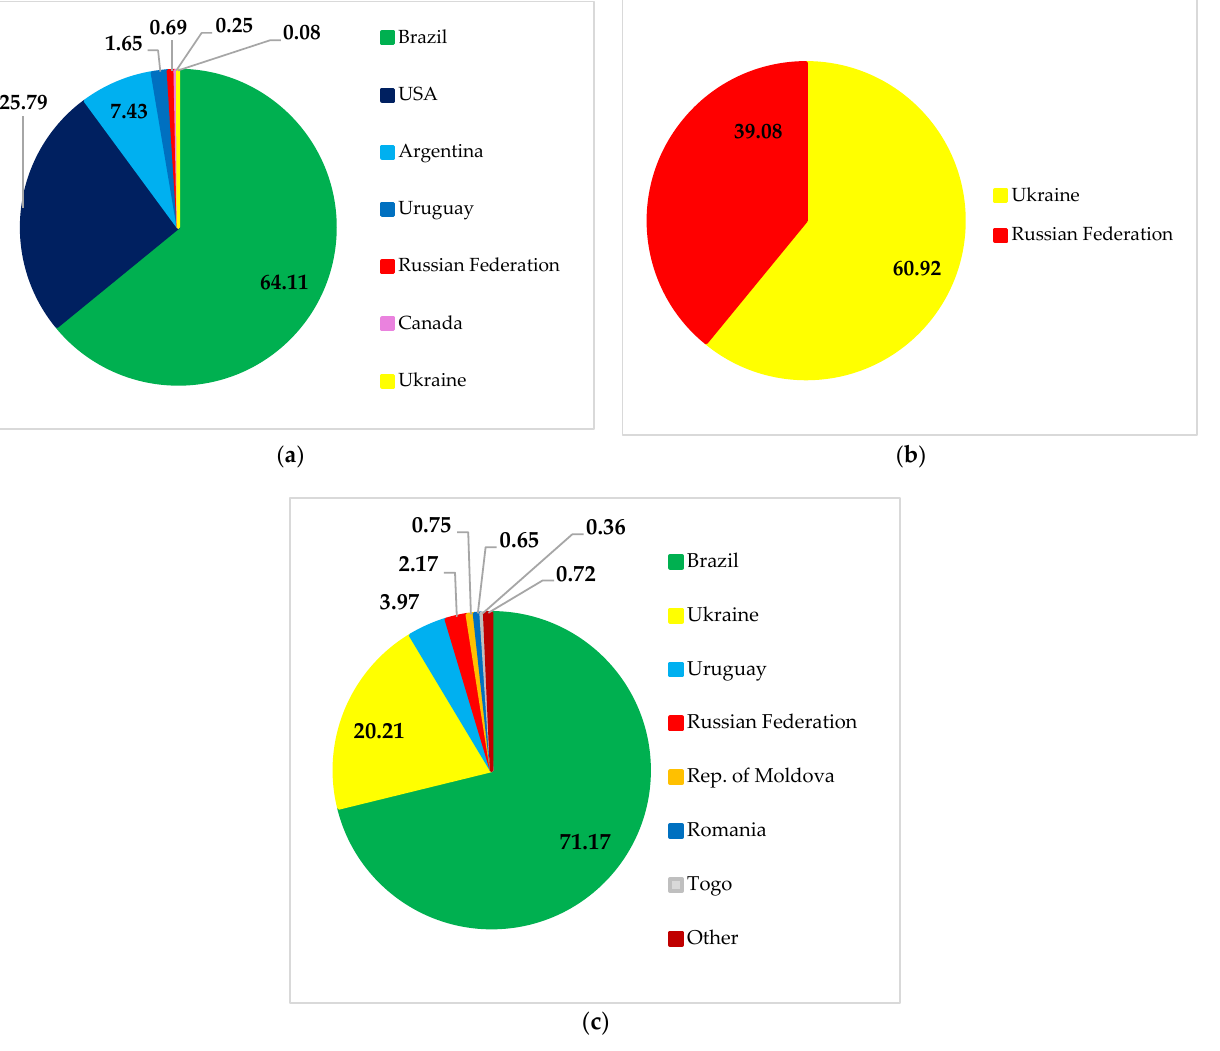
Figure 11. China’s ( a ), Belarus’ ( b ), and Turkey’s ( c ) soybean import structure. Source: [30]. Ukraine and Russia are also significant exporters of maize. The trend of maize ex- ports from Ukraine indicates a rise in 2020 and 2021. Meanwhile, Russian maize exports mainly remained stable during that period. Ukrainian maize exports peaked at the begin- ning and end of the year. Meanwhile, Russian maize exports peaked in February and April (Figure 12). Figure 12. Export quantity of Russian and Ukrainian maize in 2020 and 2021. Source: [30]. The destination countries for maize exports from Ukraine are countries with upper- middle economies, such as China, the Netherlands, Egypt, Spain, and others. Likewise, Russia also sells maize to countries such as Turkey, Vietnam, the Republic of Korea, China, and others (Figure 13).